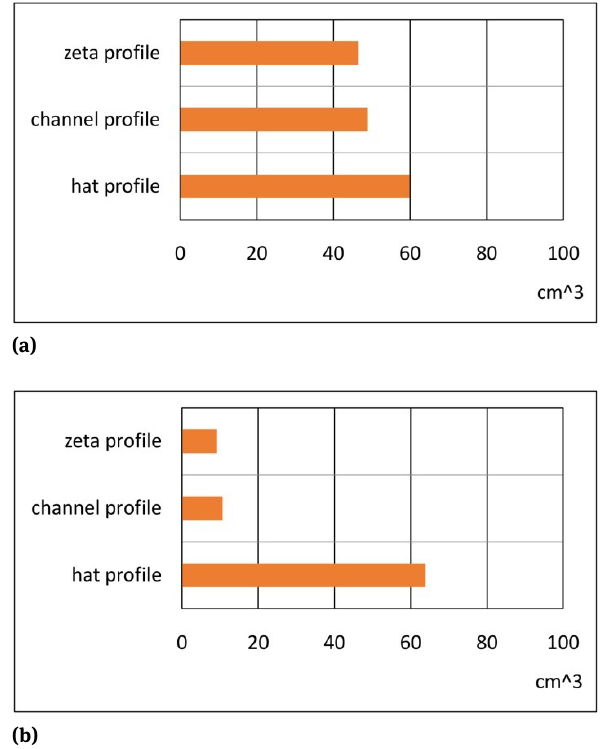
Figure 12: a) Section modulus of the effective cross-section with regard to the y-y axis W y , eff , b) Section modulus of the effective cross-section with regard to the z-z axis W z , eff